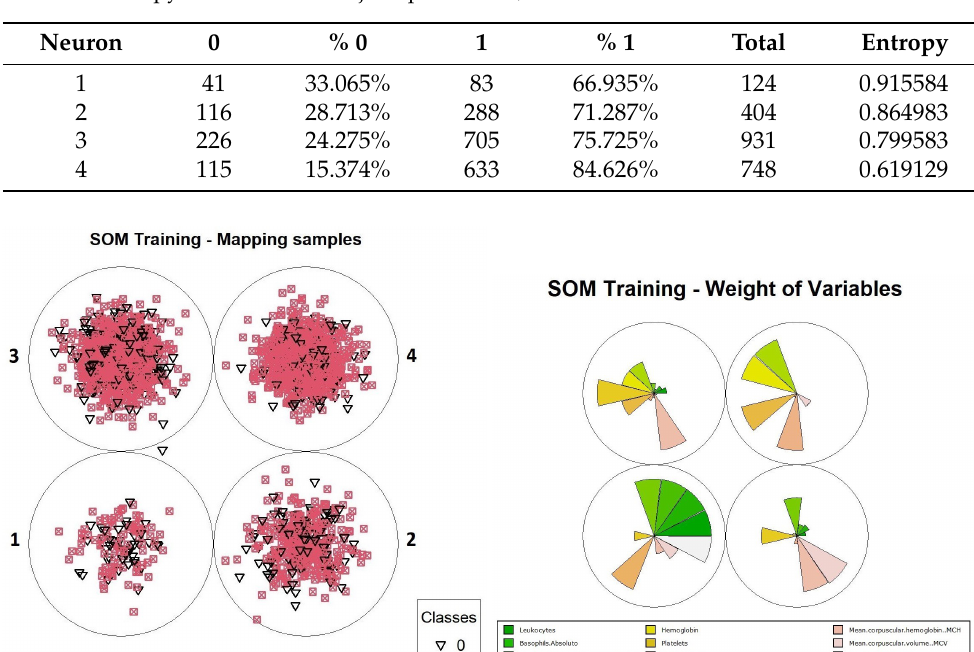
Figure 14. Training information TESSOM from levels 1, 2 and 3. Table 10. Entropy and volume of objects per neuron, level 1 TESSOM .